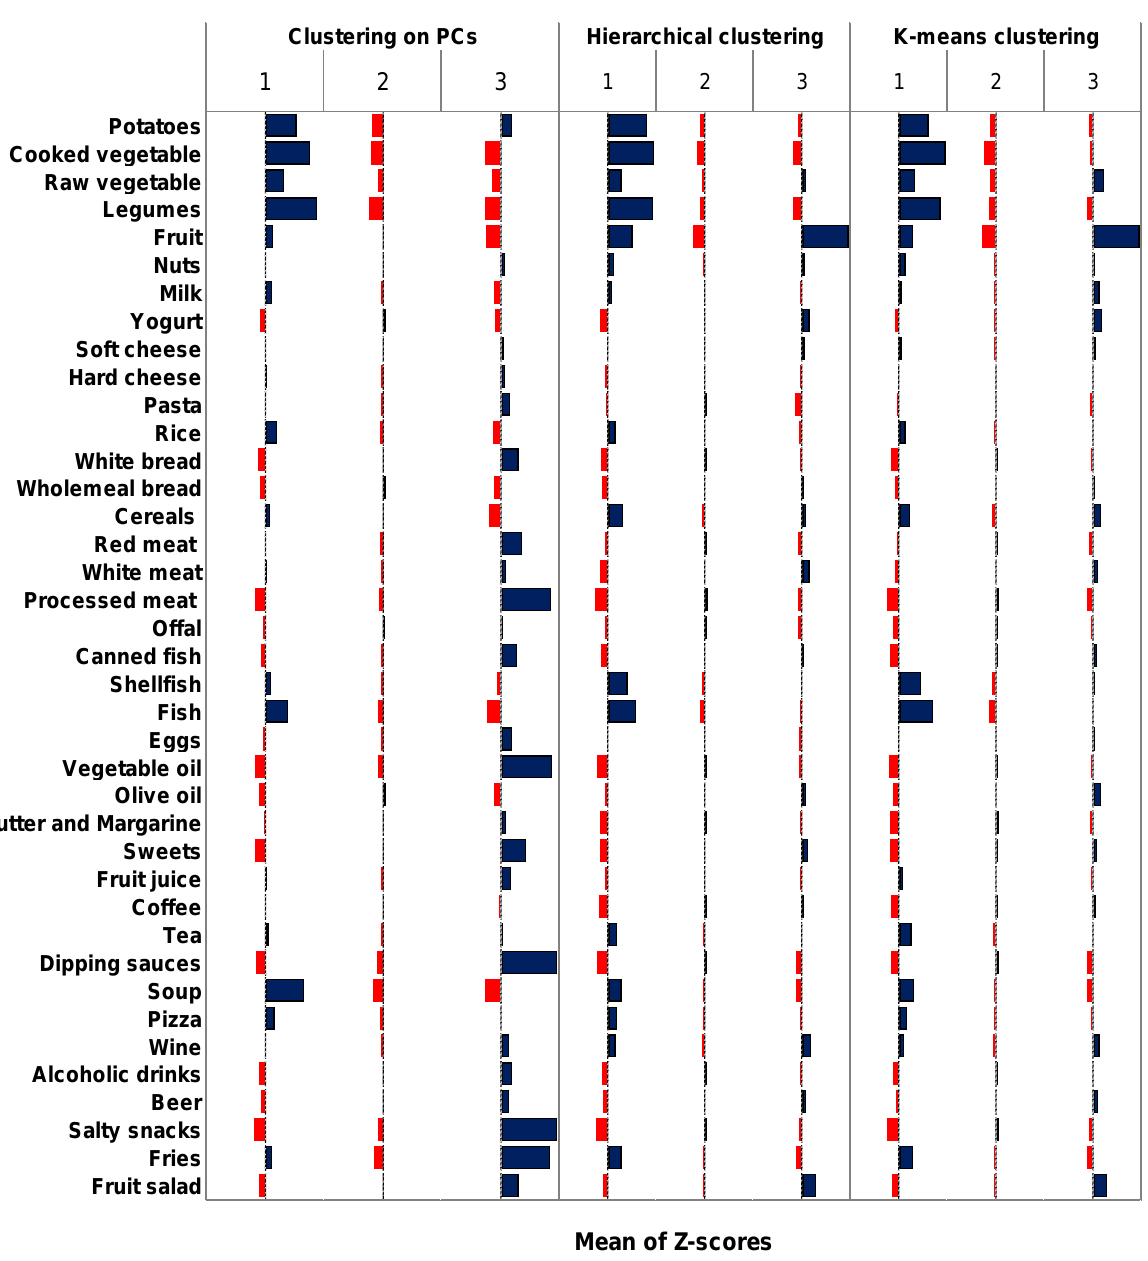
Figure 4. Comparison of z-scores of food intakes between clusters obtained through clustering of principal components, simple hierarchical clustering, and K-means clustering. Blue bars represent food categories that positively characterize the cluster. Red bars represent food categories that negatively characterize the cluster. Abbreviations: PCs, principal components.